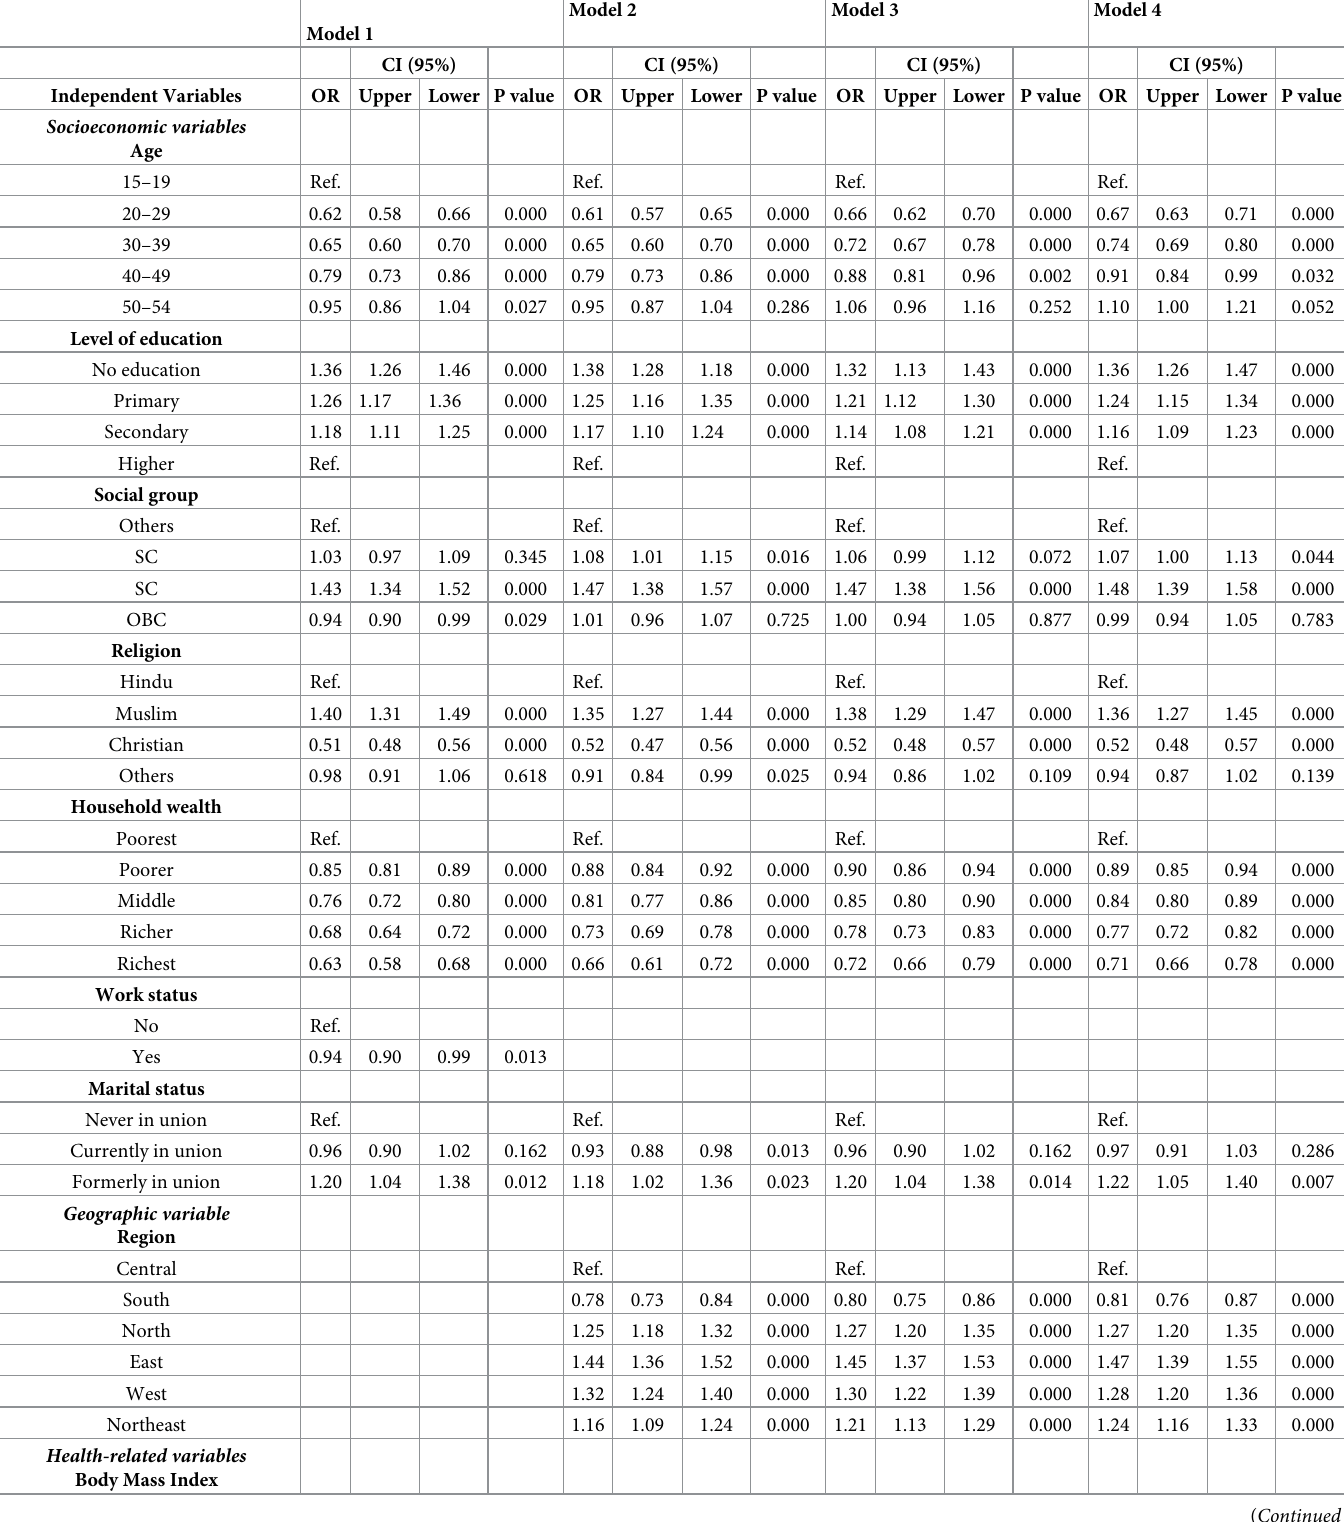
Table 4. Odds ratios (with 95% CI) for anaemia among men by their background characteristics, India, 2019–21.